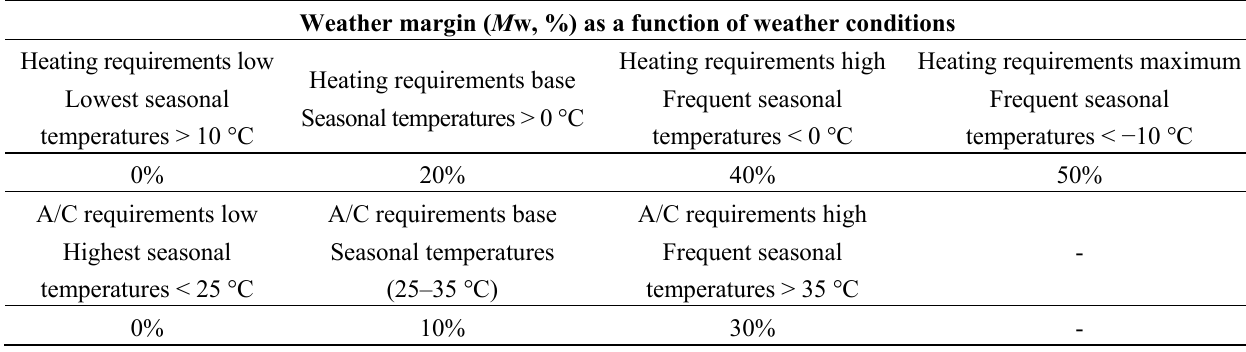
) factor values for weather w